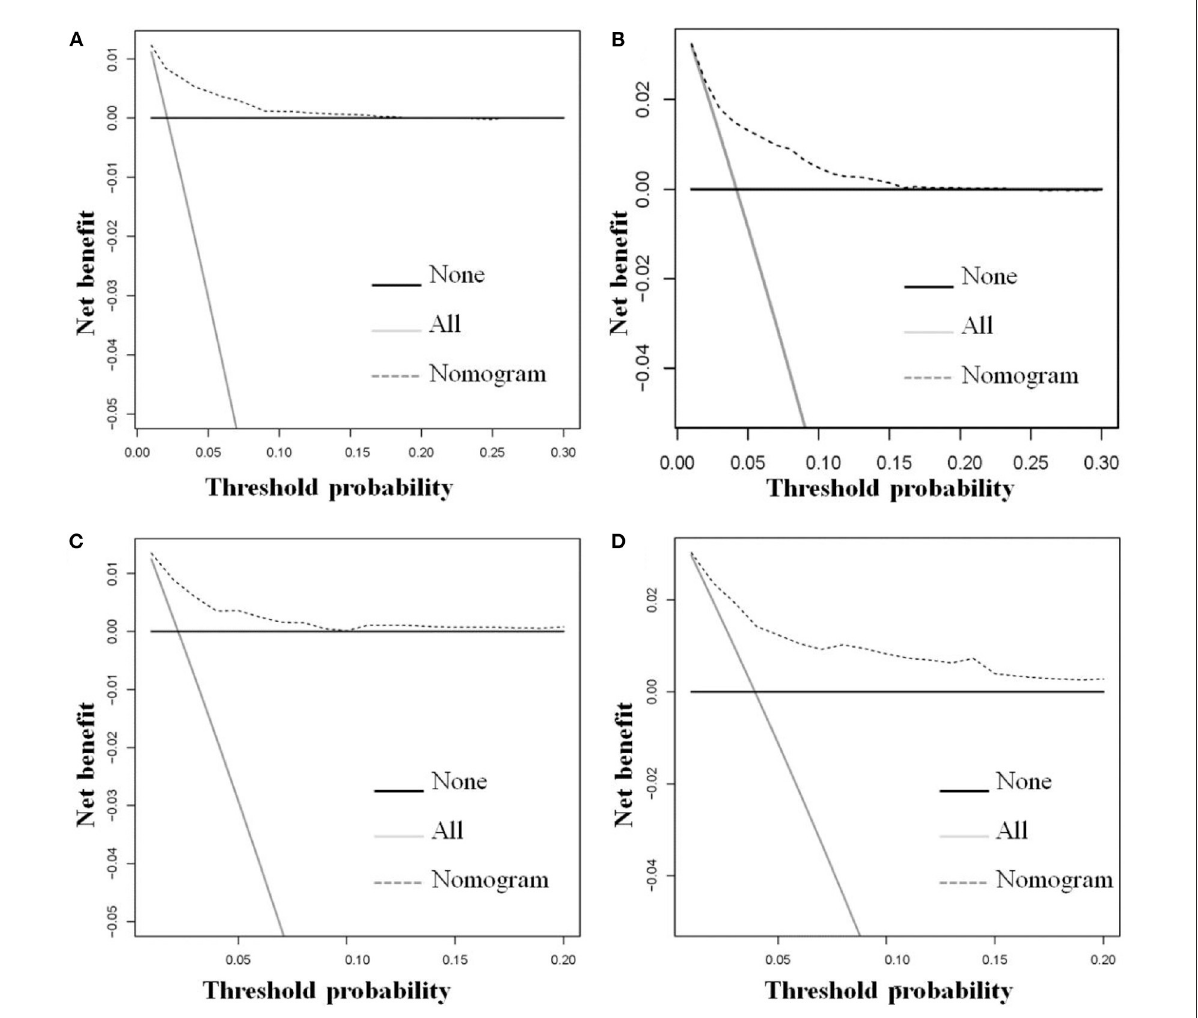
FIGURE6 The decision curve analysis of the constructed novel nomogram was used to predict the 5- (A) and 8- (B) year HDSS in the training cohort and the 5- (C) and 8- (D) year HDSS in the validation cohort for older female primary breast cancer patients that underwent